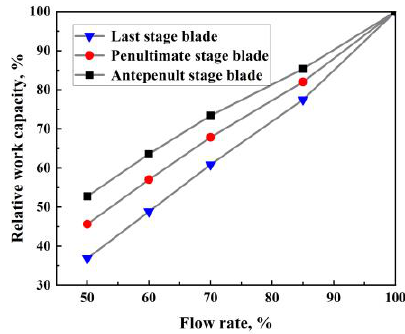
Figure 13. Amount of work performed by the last three stage blades (3.4 MPa back pressure) .